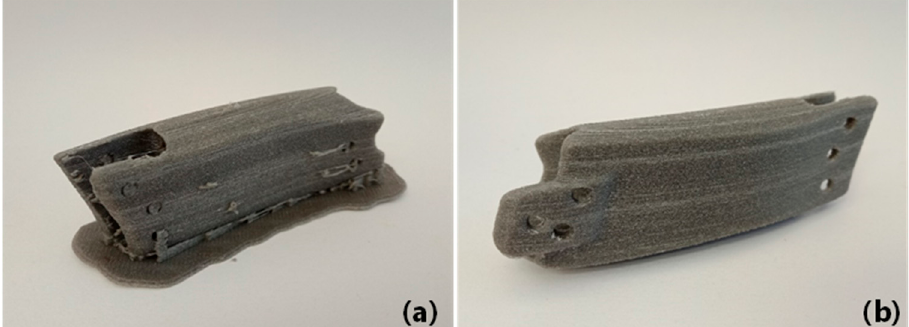
Figure 12. A jaw implant printed with 4% Mg composite filament: ( a ) before finishing; ( b ) after finishing.